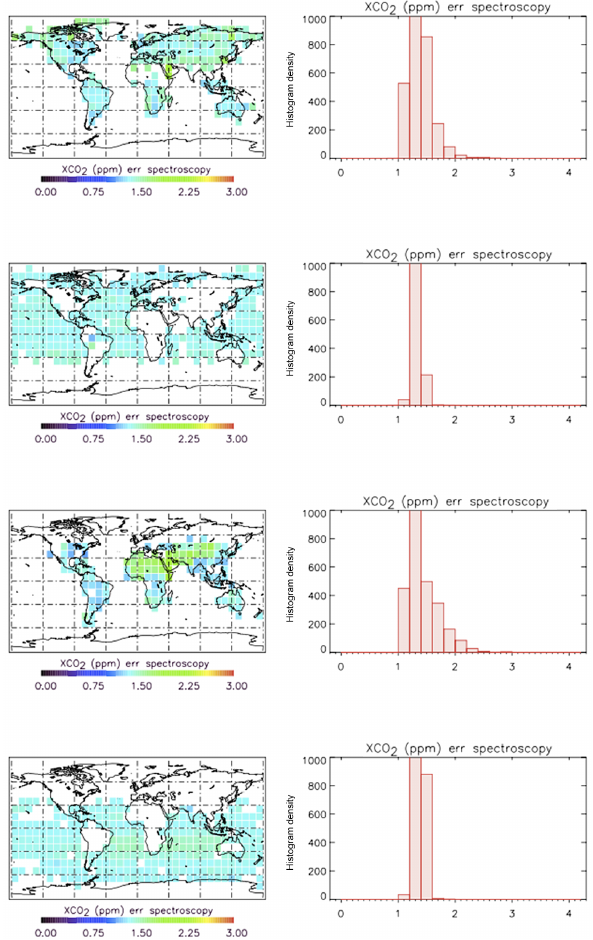
Figure 2. Error due to spectroscopy. Top: June, land; second row: June, ocean; third row: Dec., land; bottom: Dec., ocean.